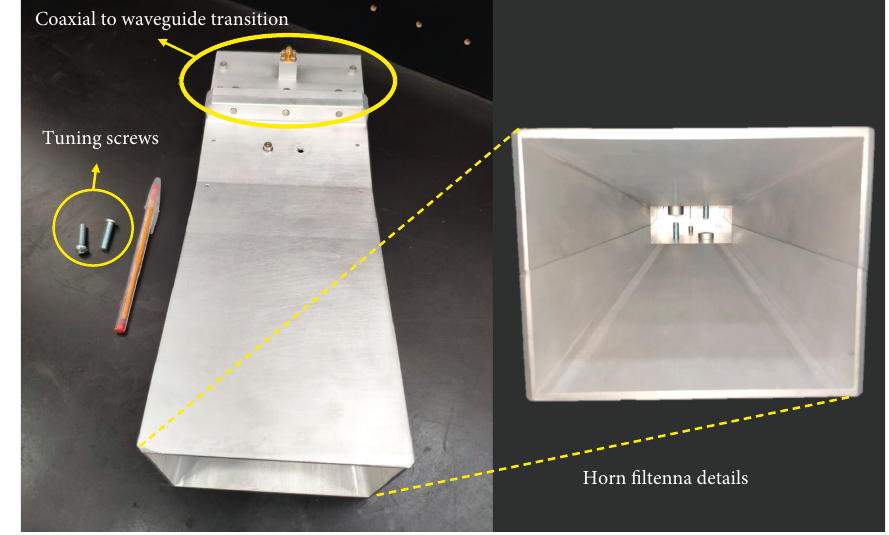
Figure 5: Microwave horn filtenna